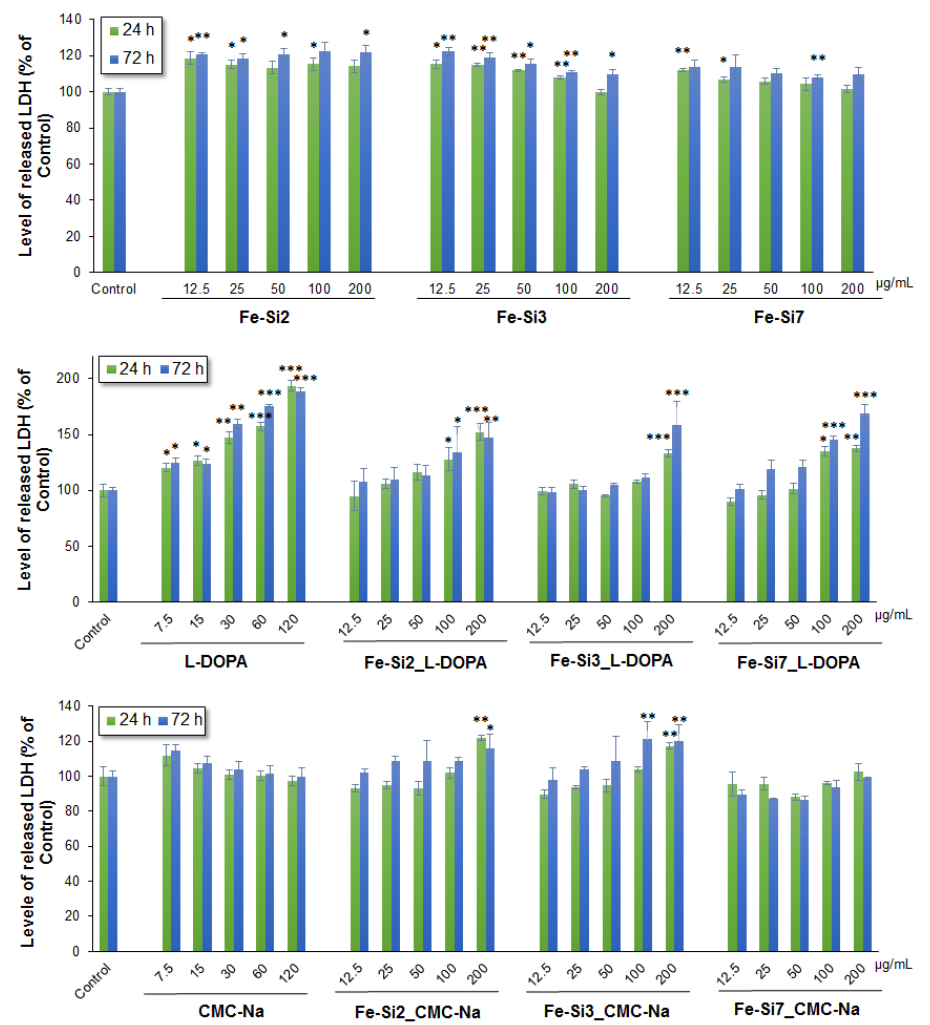
Figure 7. Level of lactate dehydrogenase (LDH) released from Caco2 cells after 24 and 72 h exposure to different doses (0–200 µg/mL) of hybrid Fe-Si NPs alone and stabilized with L -DOPA and CMC-Na (0–120 µg/mL). Data are expressed as the mean ± SD ( n = 3) and represented as percentages of untreated control (100% viability). * p < 0.05; ** p < 0.01; *** p < 0.001 versus untreated control.